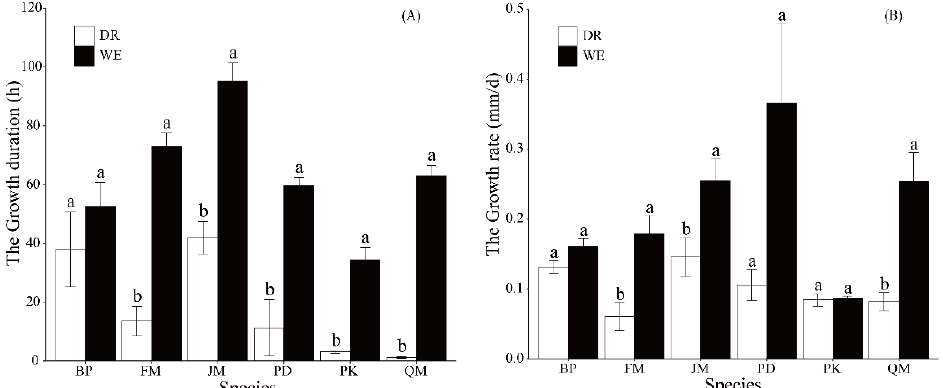
Figure 6. Comparison of growth duration ( A ) and growth rate ( B ) of six tree species during di ff erent periods. DR represents the period of seasonal drought (DOY205-211) and WE represents the period of su ffi cient moisture (DOY212-218). FM: Fraxinus mandshurica ; JM: Juglans Mandshurica Maxim.; PK: Pinus koraiensis Sieb. et Zucc.; QM: Quercus mongolica Fisch.; PD: Populus davidiana Dode.; BP: Betula platyphylla Suk. Di ff erent lowercase le tt ers indicated signi fi cant di ff erence at 0.05 level.